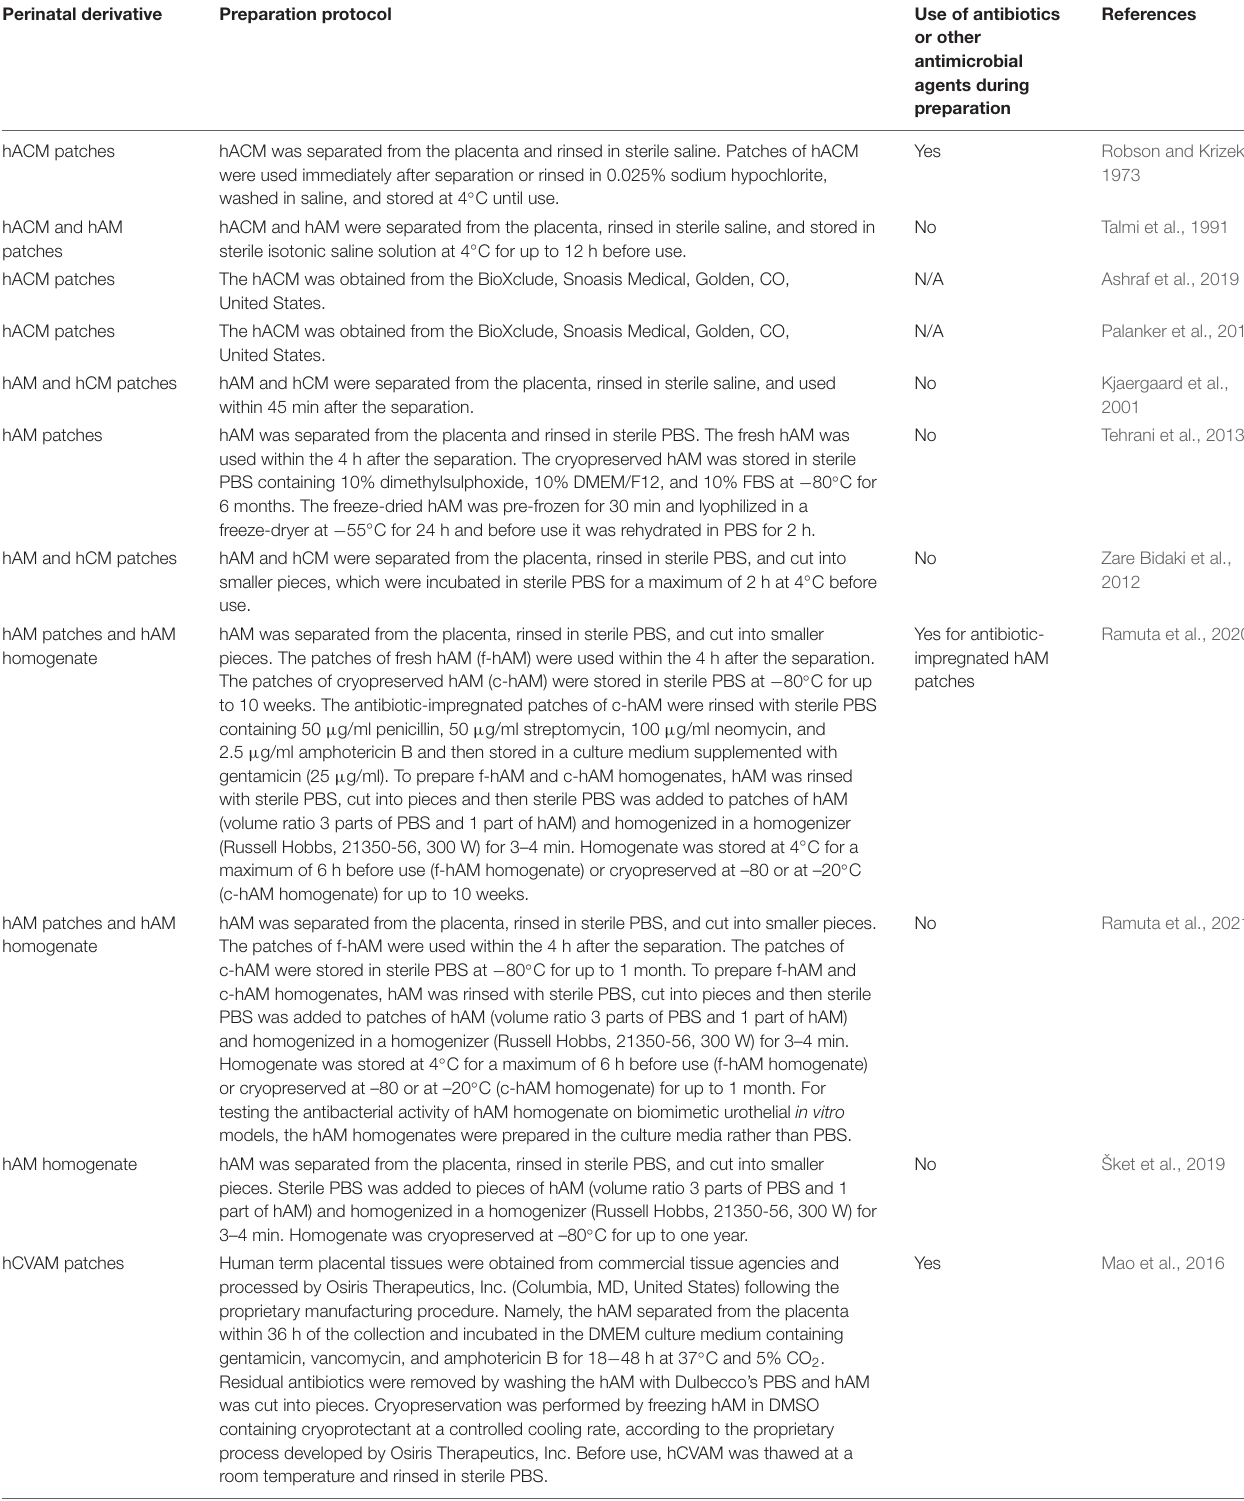
TABLE 1 | Protocols for preparation of hACM, hAM, and hCM and their derivatives, which were used for investigation of antimicrobial activity. There are many variations in protocols for the preparation of fetal membranes to be used as an antimicrobial agent, which underlines the need for protocol standardization before considering clinical